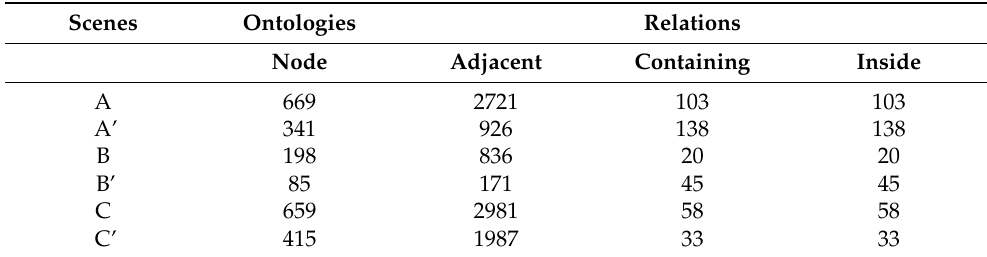
Table 2. Detailed information about ontologies and relationships in the knowledge graph and the unidentified object graph. A, B, C, A’, B’and C’ represent the knowledge graphs and the unidentified object graphs over experimental scenes A, B, and C, respectively.